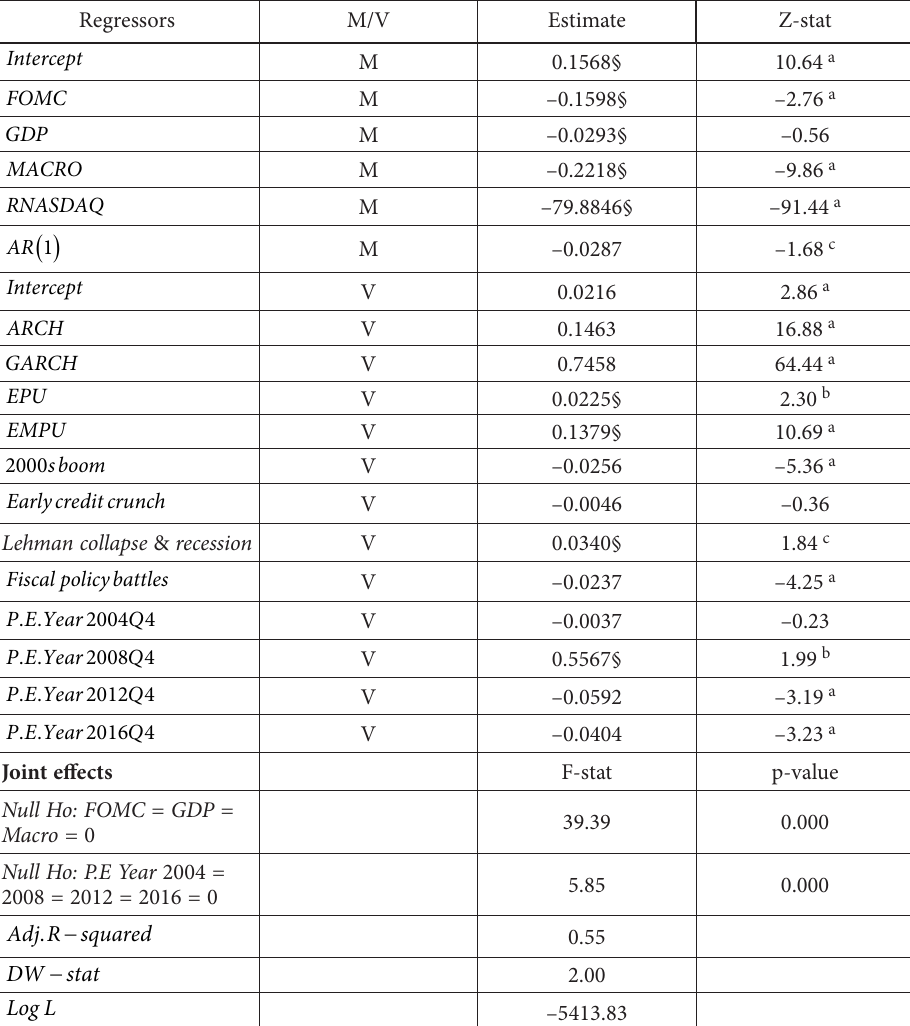
Table 5. Economic policy uncertainty and Nasdaq volatility index